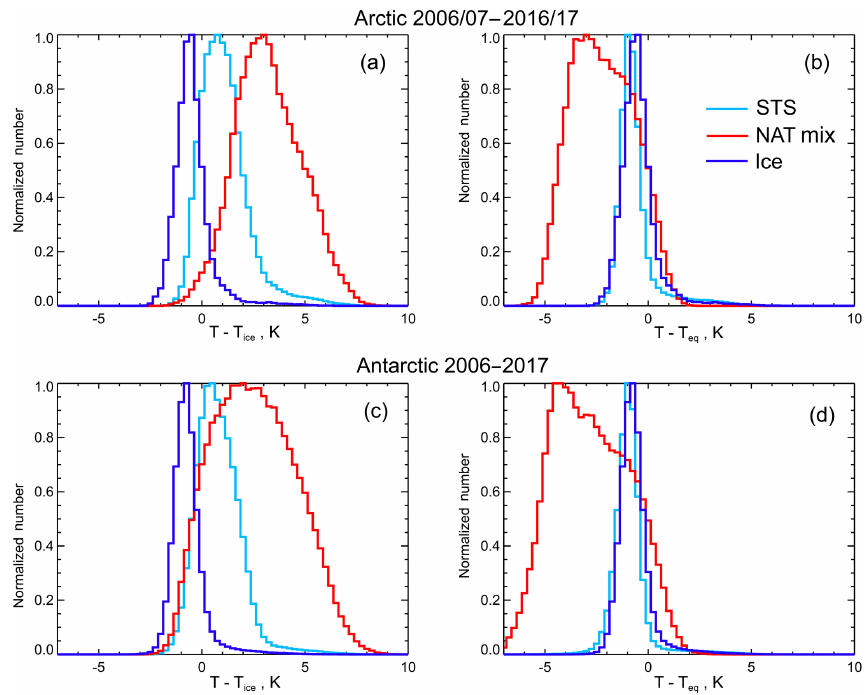
Figure 12. Histograms of CALIOP v2 PSC observations at 21km from 11 Arctic and 12 Antarctic winters as a function of (a, c) T − T ice and (b, d) T − T eq by composition: STS (light blue); NAT mixtures, including enhanced NAT mixtures (red); and ice, including wave ice (dark